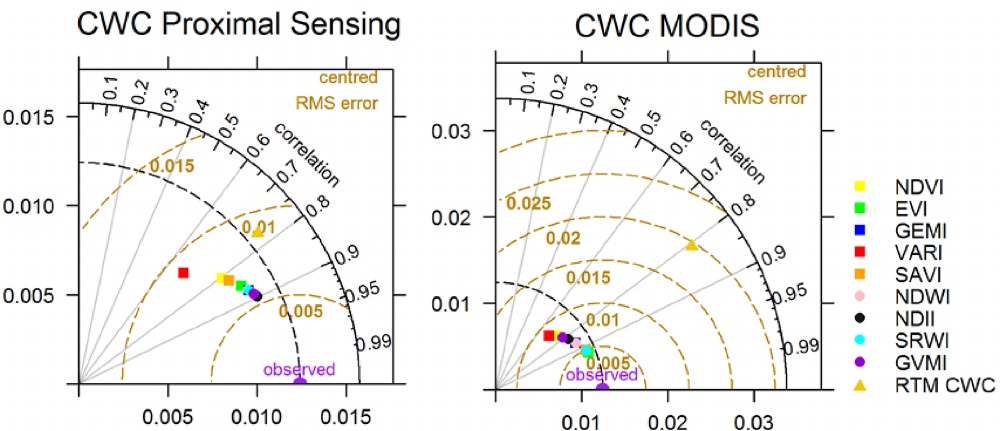
Figure 8. Comparison of empirical vs RTM models to estimate CWC with proximal sensing (left) and MODIS (right). RTM CWC is based on Trombetti et al. (2008).